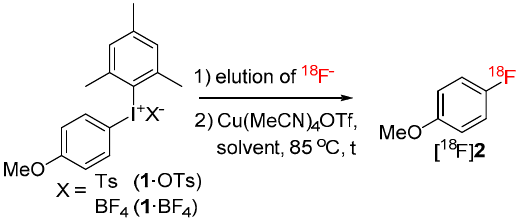
Scheme 2. Model labeling reaction used for the optimization of the reaction parameters.